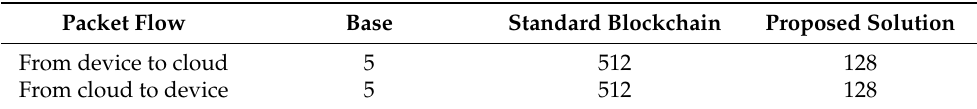
Table 2. Packet overhead (bytes) with standard blockchain. Packet Flow Base Standard Blockchain